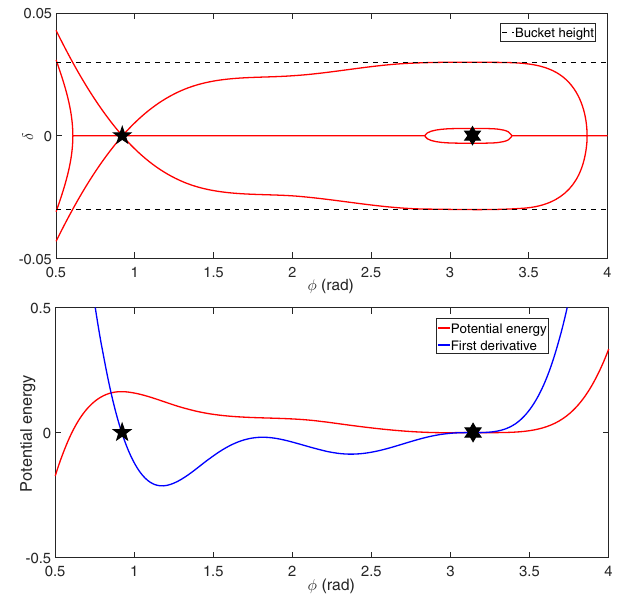
FIG. 3. Longitudinal acceptance, and potential energy, corre- sponding to the first derivative curve to be conducted using the above triple-frequency rf parameters. The black star presents the fixed point ϕ b , and the black hexagram stands for the synchrotron phase ϕ s . The different curves in the upper figure present the distinct energy deviation corresponding to 3% and a triple rms energy